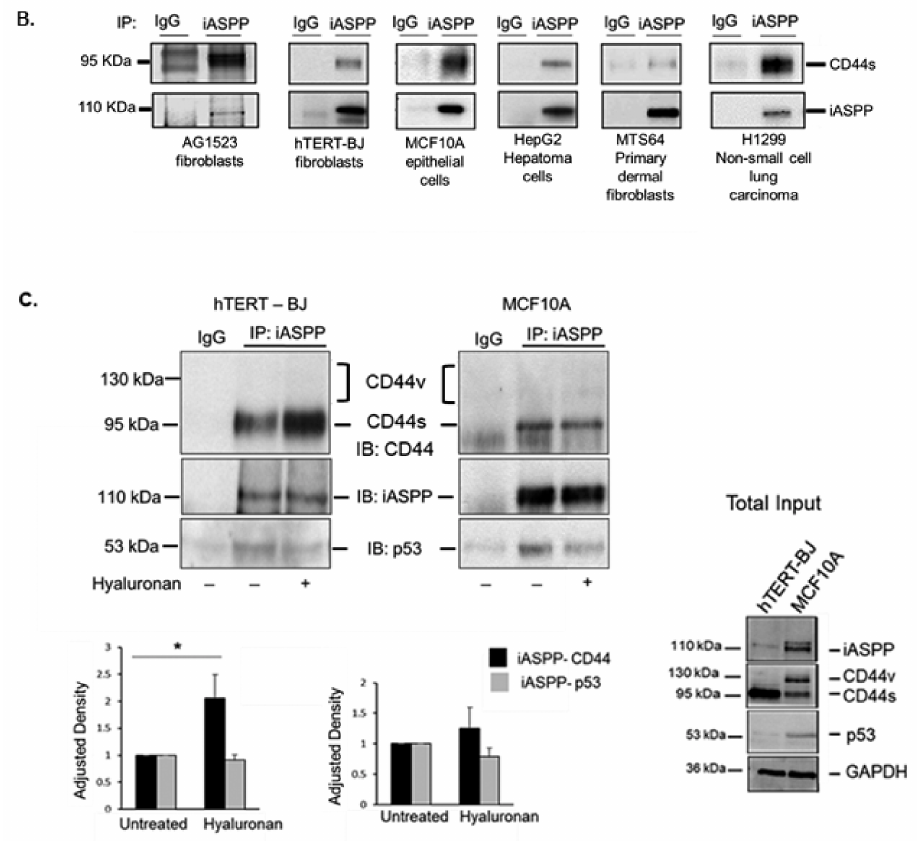
Figure 1. CD44s forms physical complexes with iASPP, both in mesenchymal and epithelial cells. ( A ) The expression levels of CD44, iASPP, and p53 were analysed in cell lysates from AG1523 fibroblasts, hTERT-BJ foreskin fibroblasts, breast cancer cells MCF-7, HEK293, lung carcinoma H1299, sarcoma U2OS, human dermal fibroblasts MTS64, and hepatoma HepG2 cells by immunoblotting (IB) with indicated antibodies, using anti-GAPDH as loading control. ( B ) Cell lysates from the selected cell lines were subjected to immunoprecipitation with an iASPP antibody or 3 µ g/mL control rabbit IgG, followed by immunoblotting for CD44 and iASPP. ( C ) hTERT-BJ fibroblasts and MCF10A cells were cultured for 24 h in starvation medium prior stimulation, or not, with hyaluronan for 45 min. Cell lysates were then subjected to immunoprecipitation, using an iASPP antibody or control rabbit IgG, followed by immunoblotting with CD44, iASPP, and p53 antibodies. Note the absence of co-immunoprecipitated band at the expected position of CD44v just above the CD44s band. A representative experiment out of three performed is shown; lower panel in C indicates fold-change of mean values ± SD. of three independent experiments: * p < 0.05, Student’s t -test; significant difference compared with unstimulated cells. The uncropped blots are shown in File